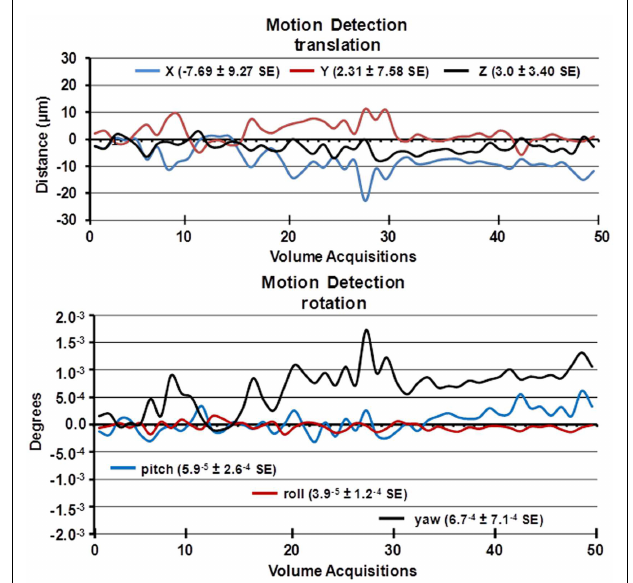
FIGURE 2 | Motion detection following acclimation .Time-course date for motion detection from 29 awake mice imaged for 5min is shown.Two and a half minute into the scanning session, mice were challenged with 5% carbon dioxide (see Figure 3 ).The data stability were estimated by a 3D rigid body model with 6 degrees of freedom for translational and rotational